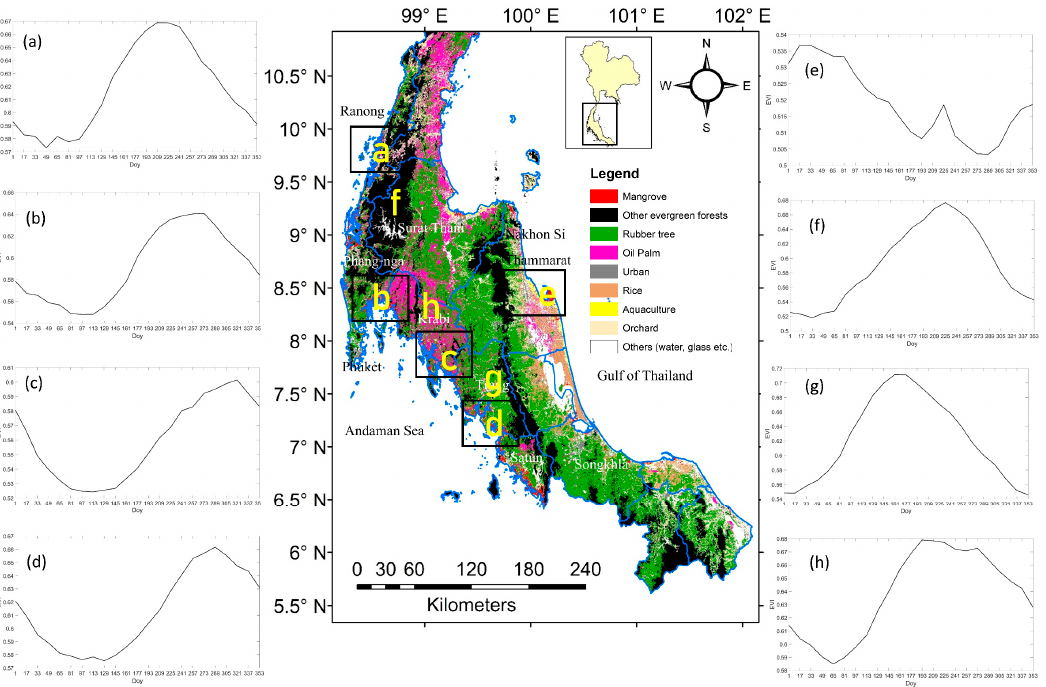
Figure 3. Averaged Enhanced Vegetation Index (EVI) seasonal patterns over 13 years (2002–2014) of ( a ) Ranong mangrove, ( b ) Phang-nga mangrove, ( c ) Krabi mangrove), ( d ) Trang mangrove, ( e ) Nakhon Si Thammarat mangrove, ( f ) Other evergreen forest, ( g ) Rubber tree plantations and ( h ) Oil palm plantations.